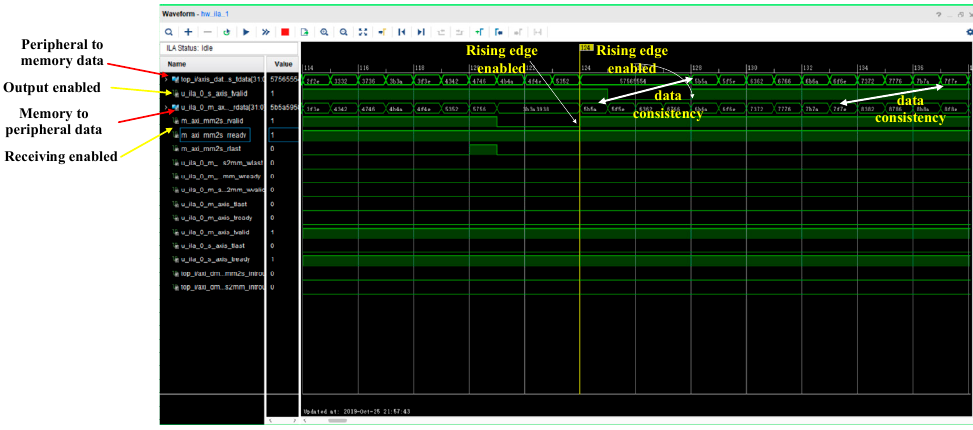
Figure 25. DMA data flow test chart.